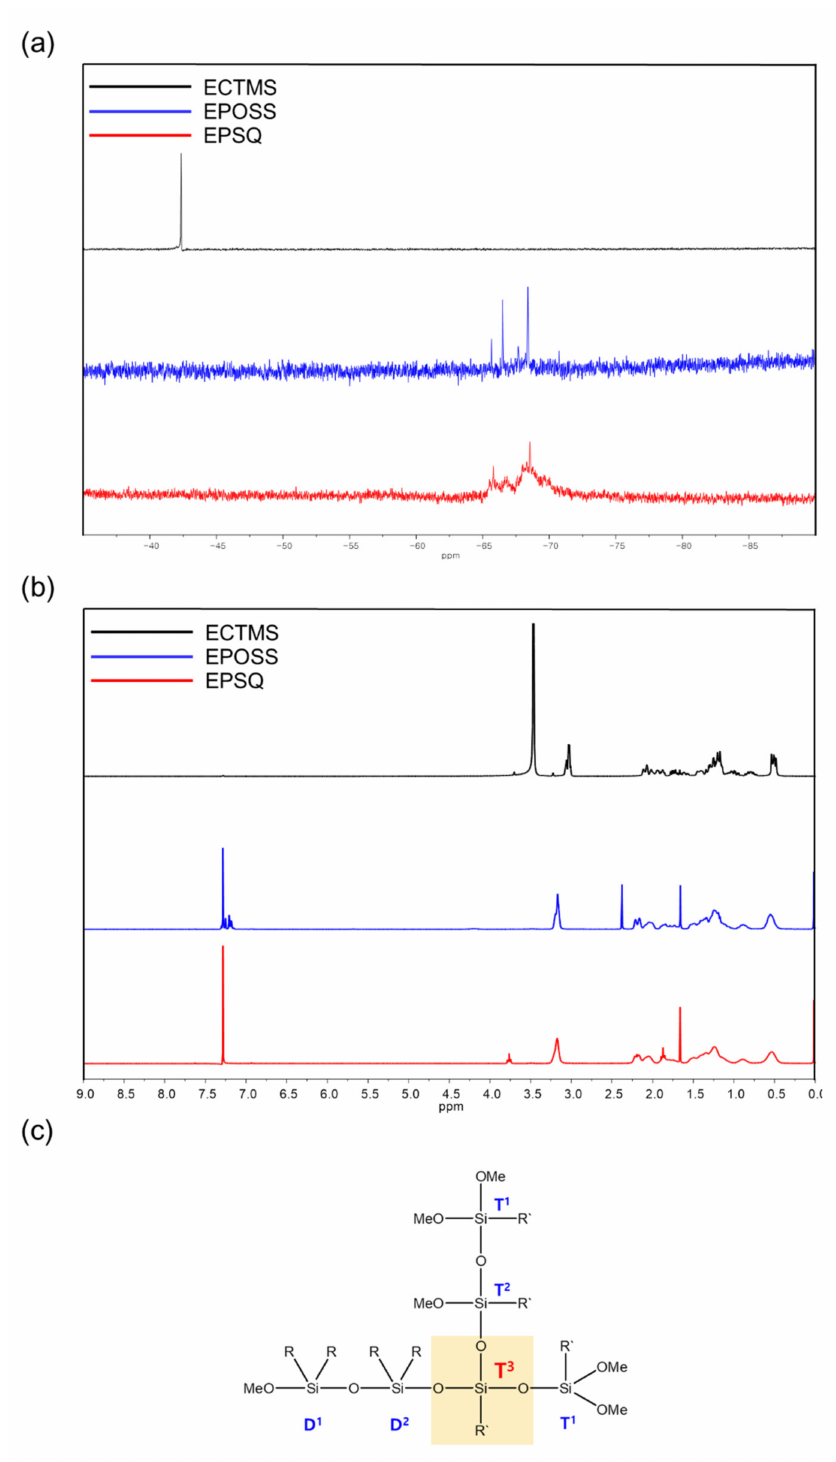
Figure 1. NMR spectra of ECTMS, EPOSS, and EPSQ. ( a ) 1 H NMR, ( b ) 29 Si NMR, and ( c ) various types of silicon